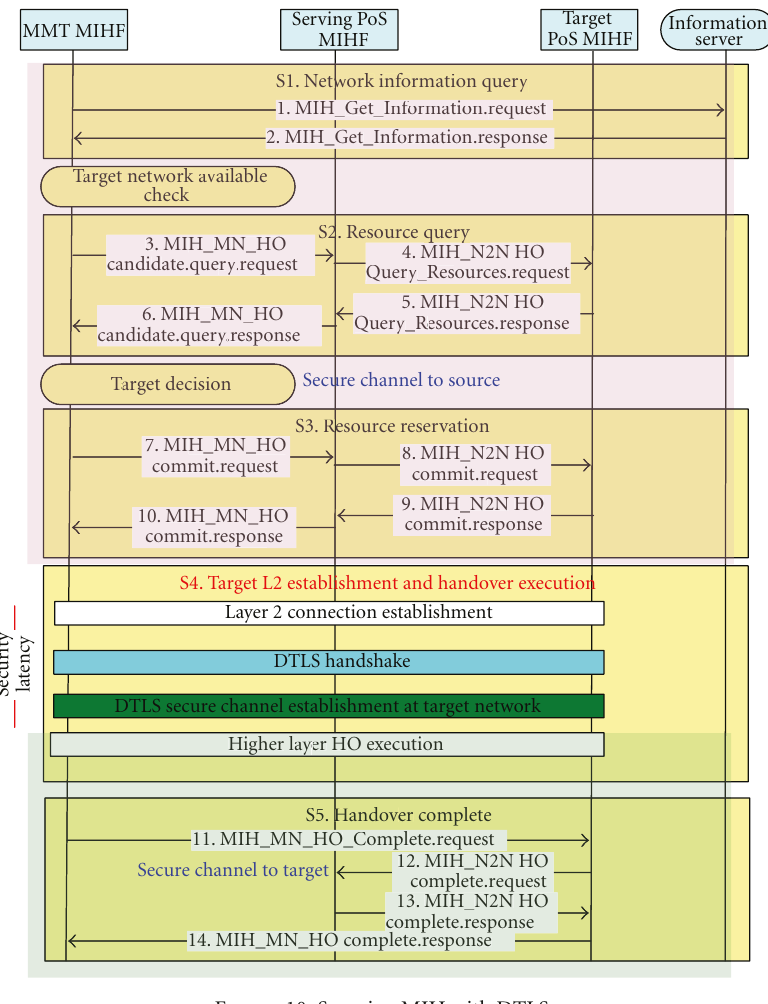
Figure 10: Securing MIH with DTLS.